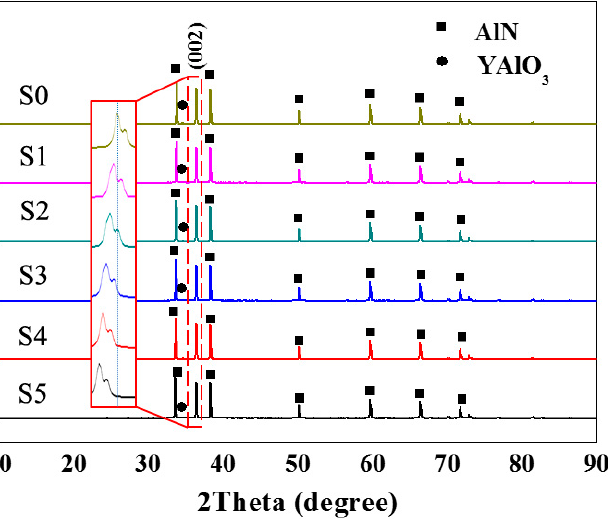
Figure 10. XRD of AlN ceramics prepared with modified AlN powder stored for 1 year.